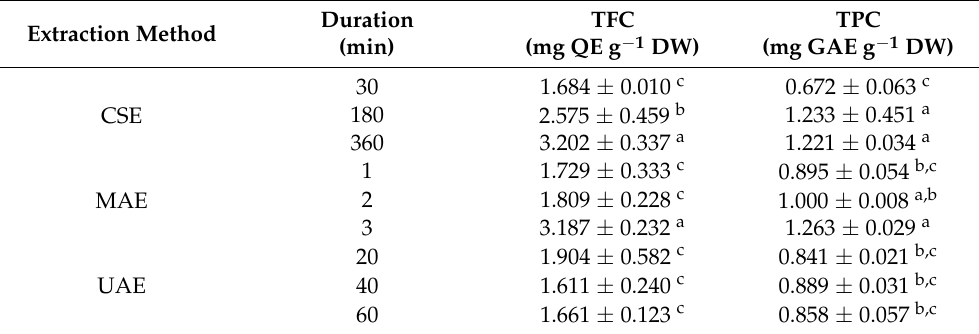
Table 1. Total flavonoid and phenolic contents (TFCs and TPCs) of methanol extracts of A. compactum obtained by different extraction methods.